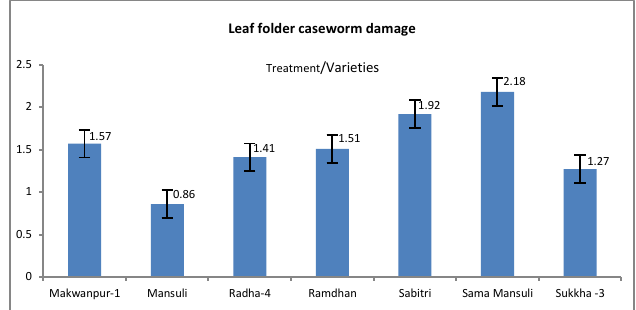
Figure 1: Average leaf folder and caseworm damage in different rice varieties.